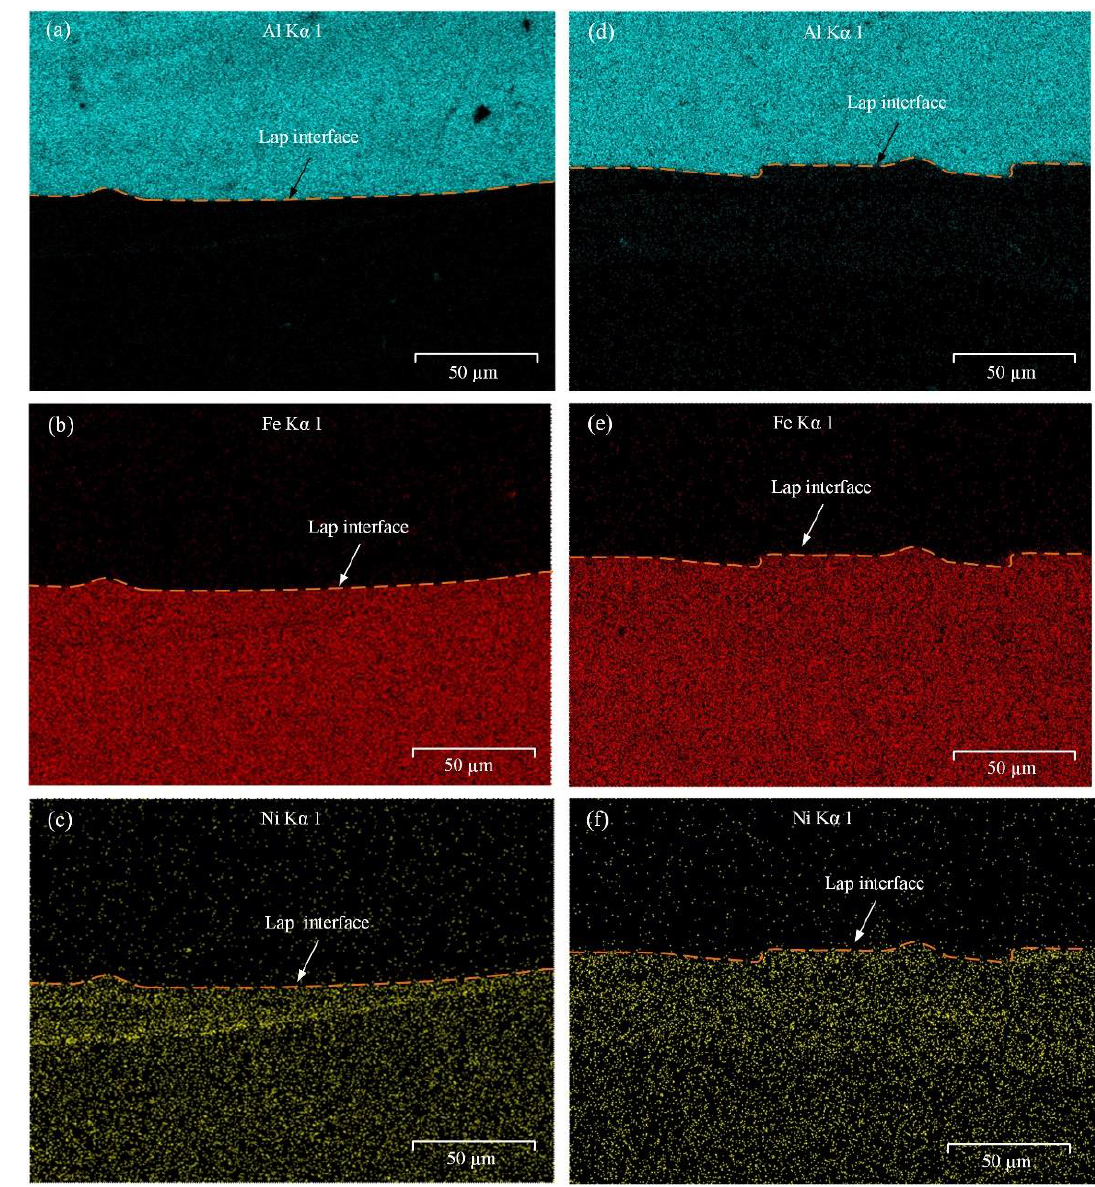
Figure 4. EDS analysis results of region B: ( a – c ) 800 rpm; ( d – f ) 1200 rpm.